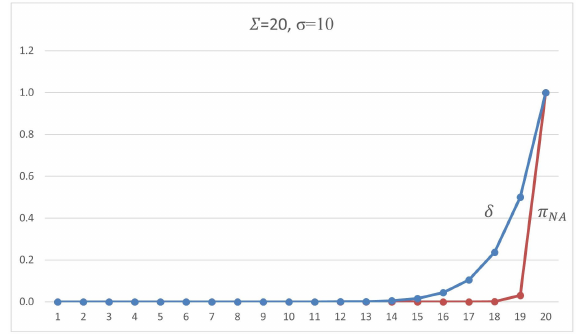
Figure 16. Relation between the number of packets the adversary manipulates, the probability of hitting valid signatures δ and the probability π NA of invalidating an authentication, working with σ = 10. In this case, the adversary has a chance only after dropping the total of the packets. With these settings, the all-or-nothing nature of our defense scheme is